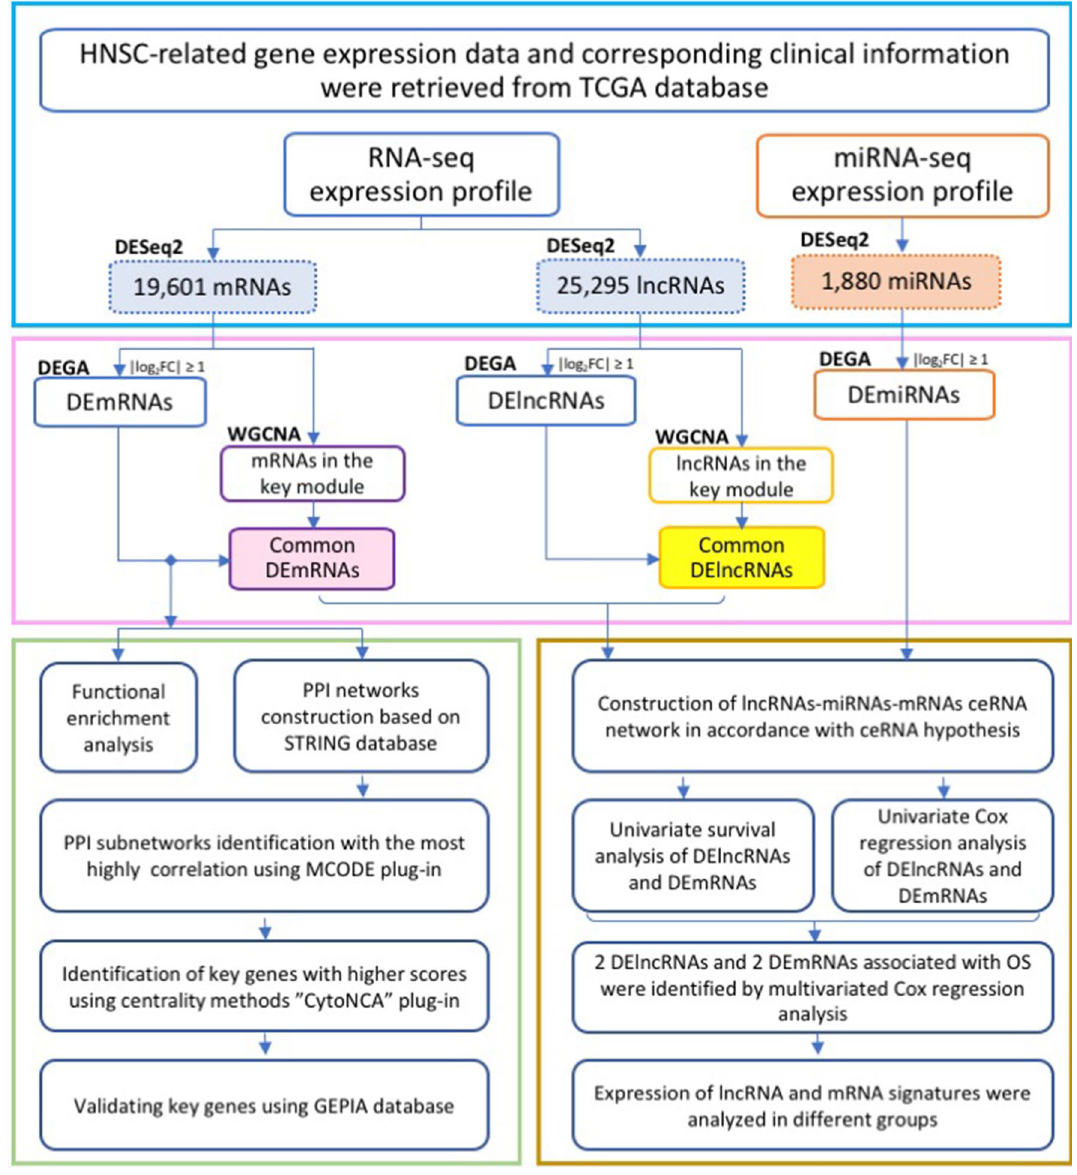
Figure 1. Flow chart of data preparation, processing, analysis and validation in this